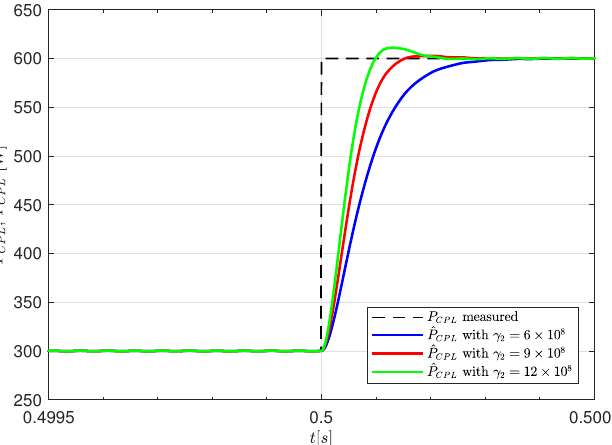
Figure 4. Effect of γ 2 in the estimated load power with γ 1 = 50 × 10 3 s − 1